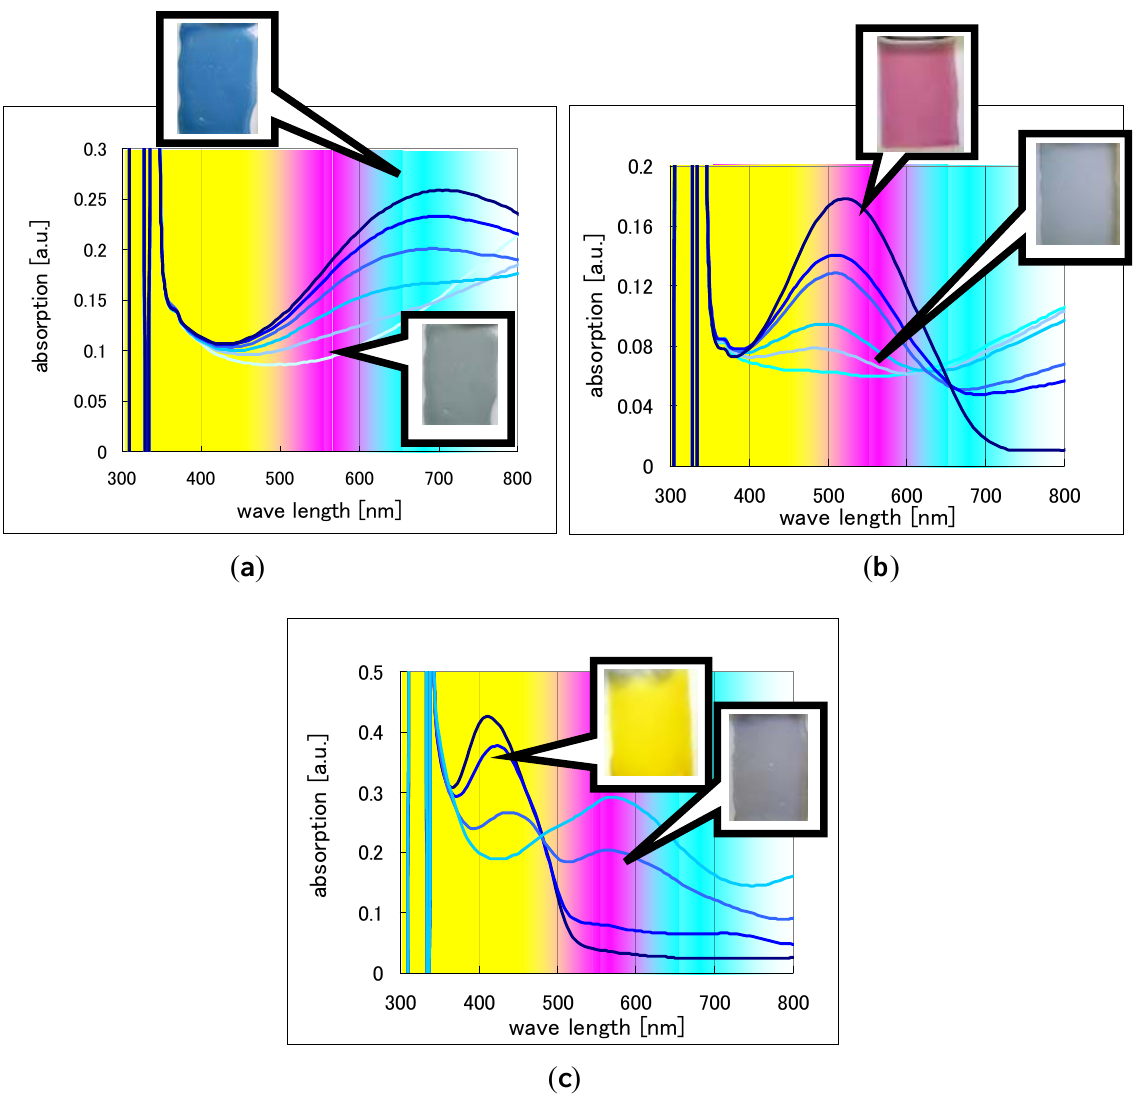
Figure 6. UV-Vis spectra of each color ( a ) Cyan; ( b ) Magenta; and ( c )